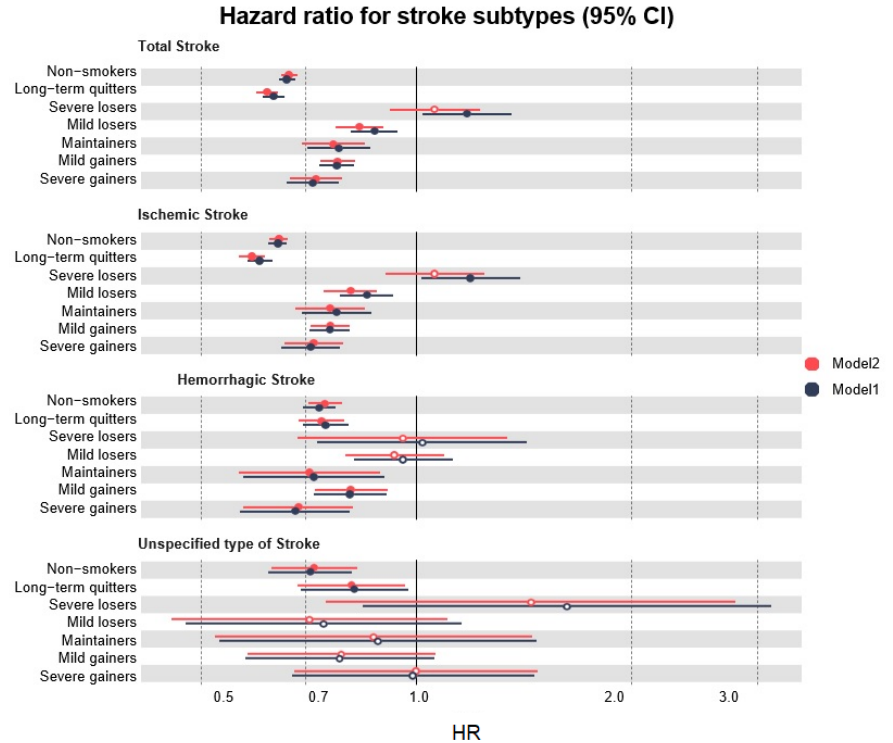
Figure 3. Multivariate models showing the effect of smoking cessation and weight changes in recent quitters on stroke subtypes. 95% CI, 95% confidence interval; HR, Hazard Ratio.